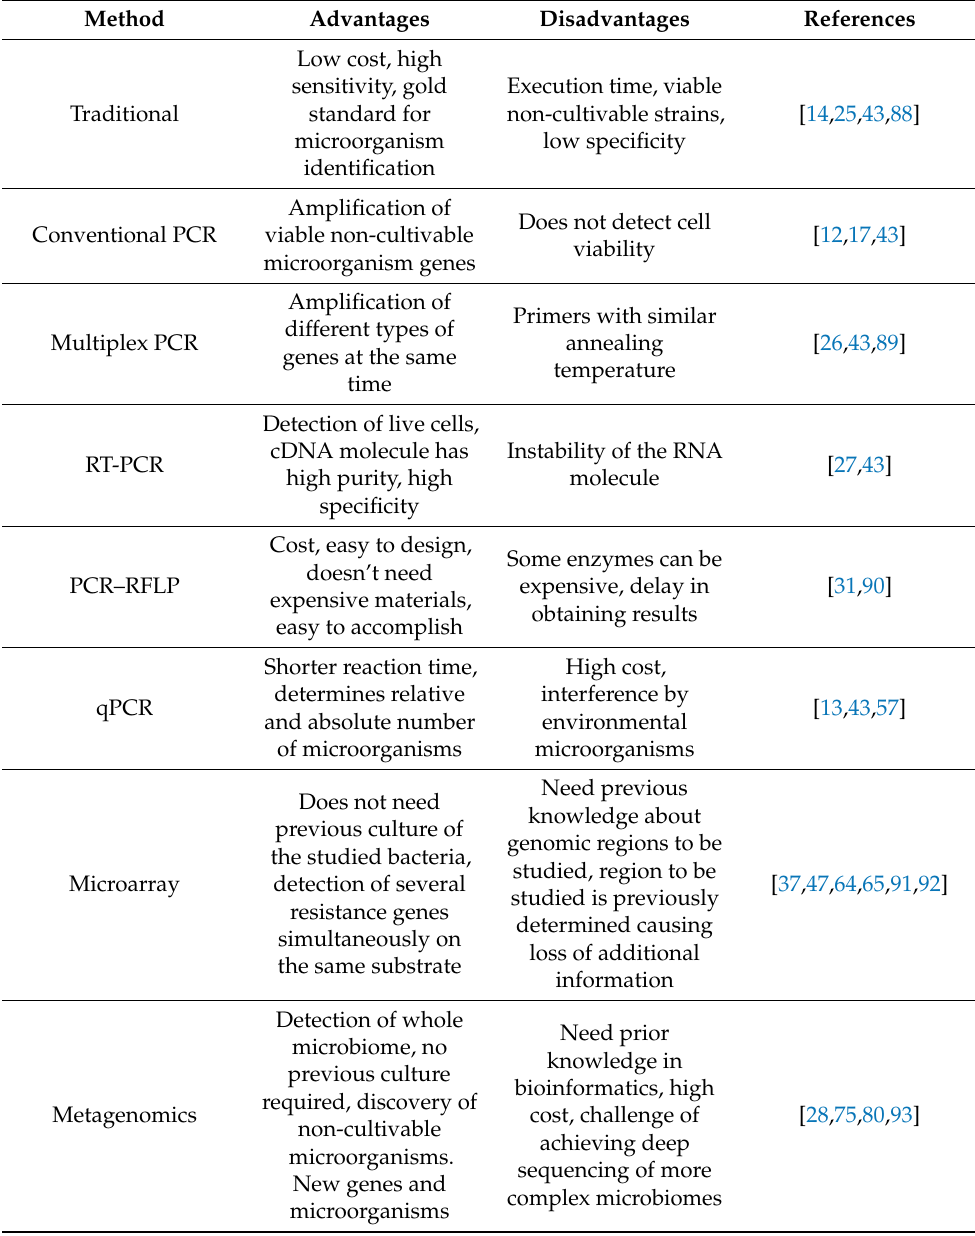
Table 1. Summary of the advantages and disadvantages of the most common traditional and molecular methods for the identification of microorganisms and antimicrobial resistance